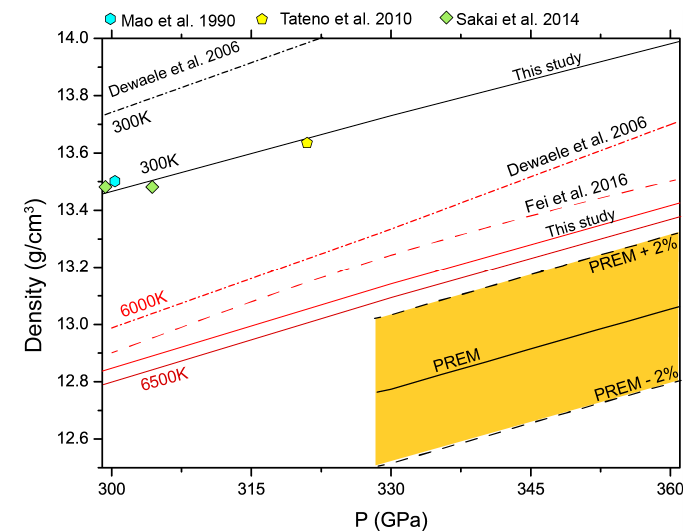
Figure 6. Density over pressure plot in the pressure range representative of the Earth’s inner core. Densities calculated from the present thermal equation of state are compared those from literature. Densities from the seismological reference of the PREM are shown with a 2% error bar. For [29] only points at or above 300 GPa are shown.